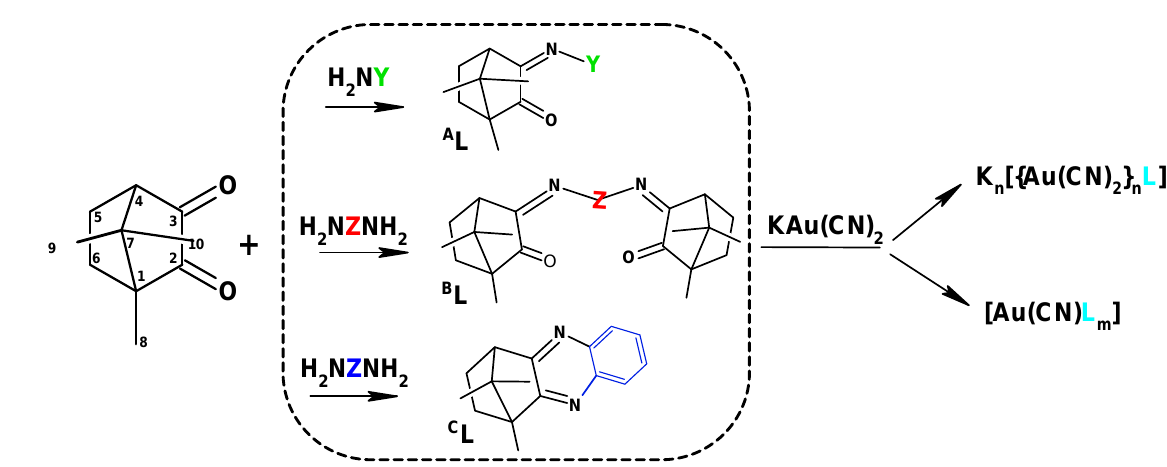
Scheme 1. Scheme for synthesis of the Au(I) complexes from camphorimine ( A L), bi-camphor ( B L), or camphor phenazine ( C L) types.